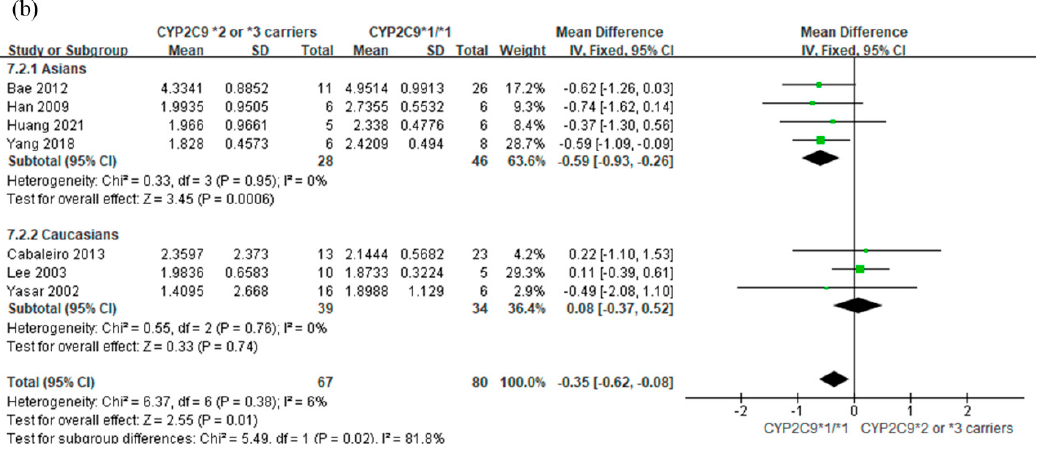
Figure 4. Forest plot with subgroups of Asians and Caucasians for comparing the mean difference between CYP2C9*2 or *3 carriers and CYP2C9*1/*1. ( a ) AUC 0- ∞ ( μg ∙ h/mL ) of losartan and ( b ) AUC 0- ∞ ( μg ∙ h/mL ) of E-3174.